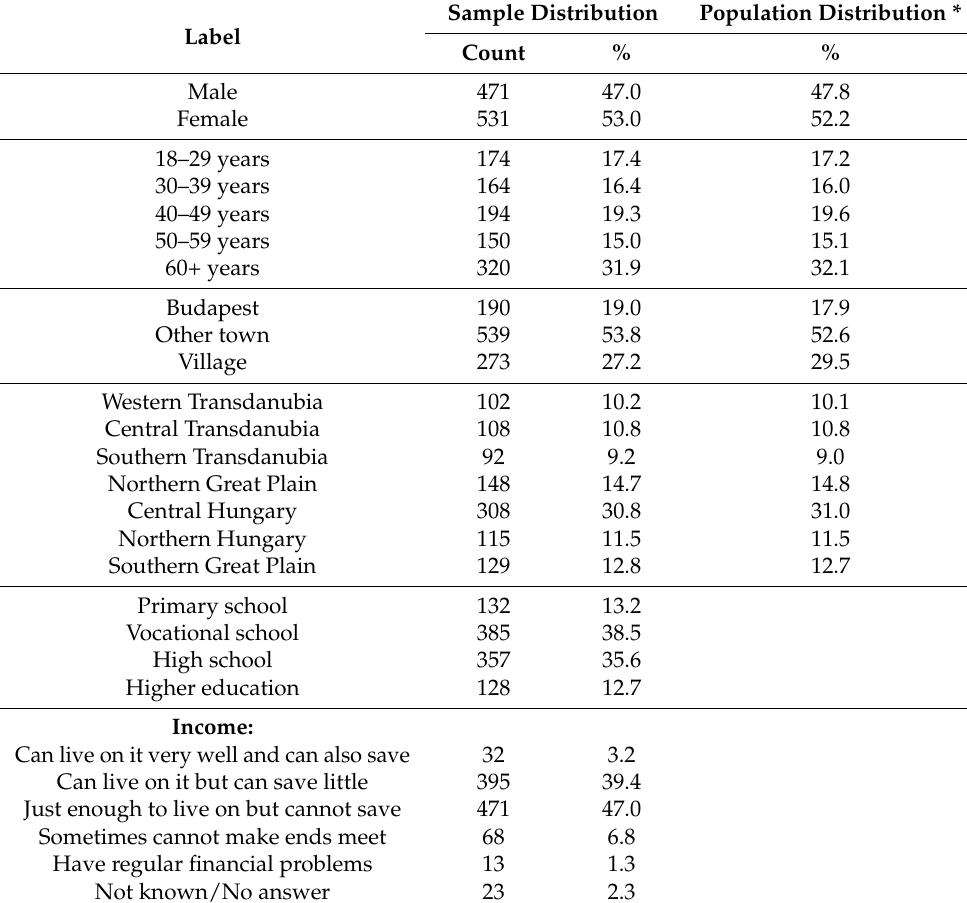
Table 2. Distribution of the sample according to the most important background variables ( N = 1002) and population composition according to representative variables. Sample Label